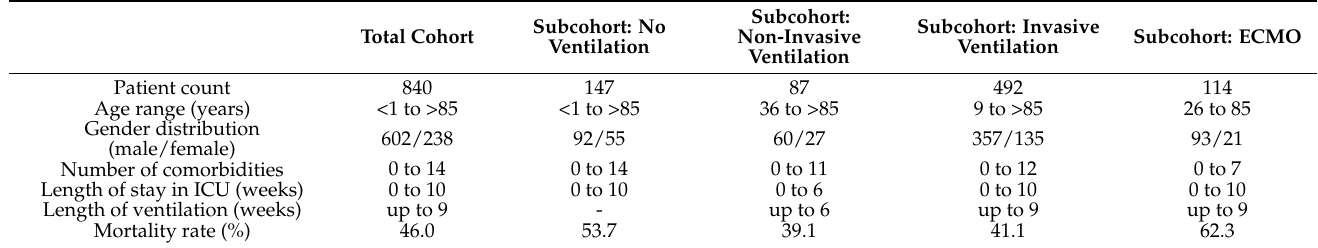
Table 1. Epidemiological data of the total cohort, as well as subcohorts, subdivided according to the type of ventilation performed. ECMO: extracorporeal membrane